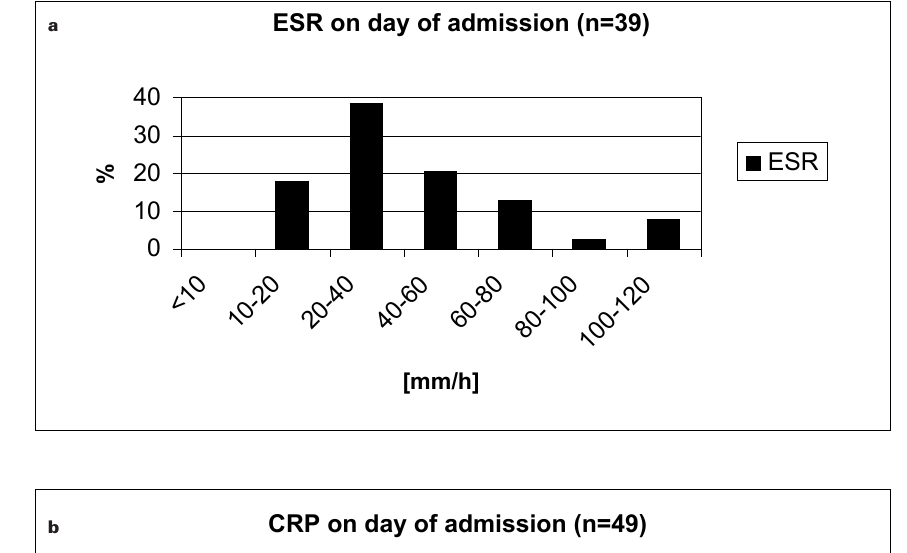
Distribution of laboratory results in patients with acute hematogenous osteomyelitis and/or septic